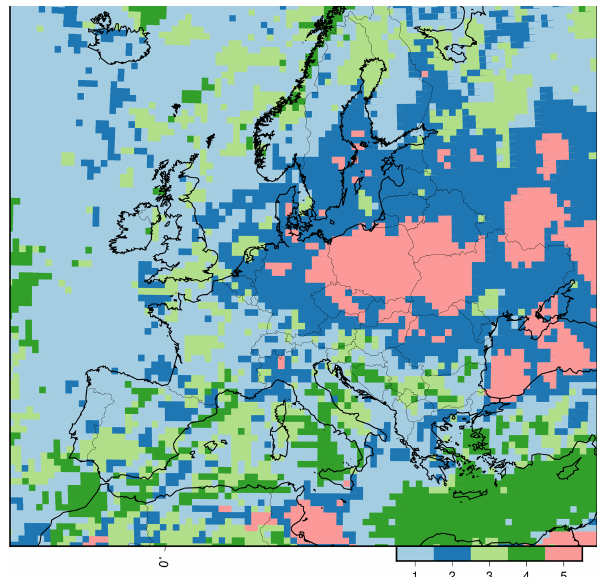
Figure 6. Cluster analysis of rainy days: each color depicts a cluster with different behavior of the ARCI–BASE difference in number of days of precipitation over a threshold running from 0.1mm to 20mmd − 1 for the period